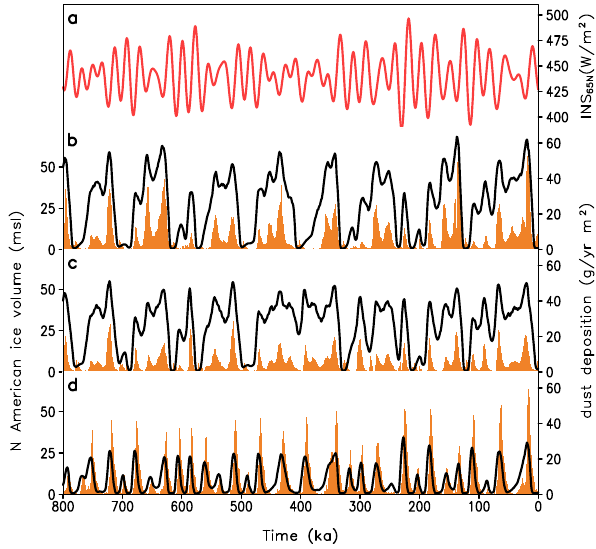
Fig. 4. (a) Maximum summer insolation at 65 ◦ N; (b) simulated volume of the North American ice sheet in msl (black line) and dust deposition rate (orange) at the southern margin of the ice sheet in the Baseline experiment, (c) the same as (b) but for the CC200 experiment, (d) the same as (b) but for REG200 experiment. The dust deposition rate is sampled at the location (45 ◦ N, 100 ◦